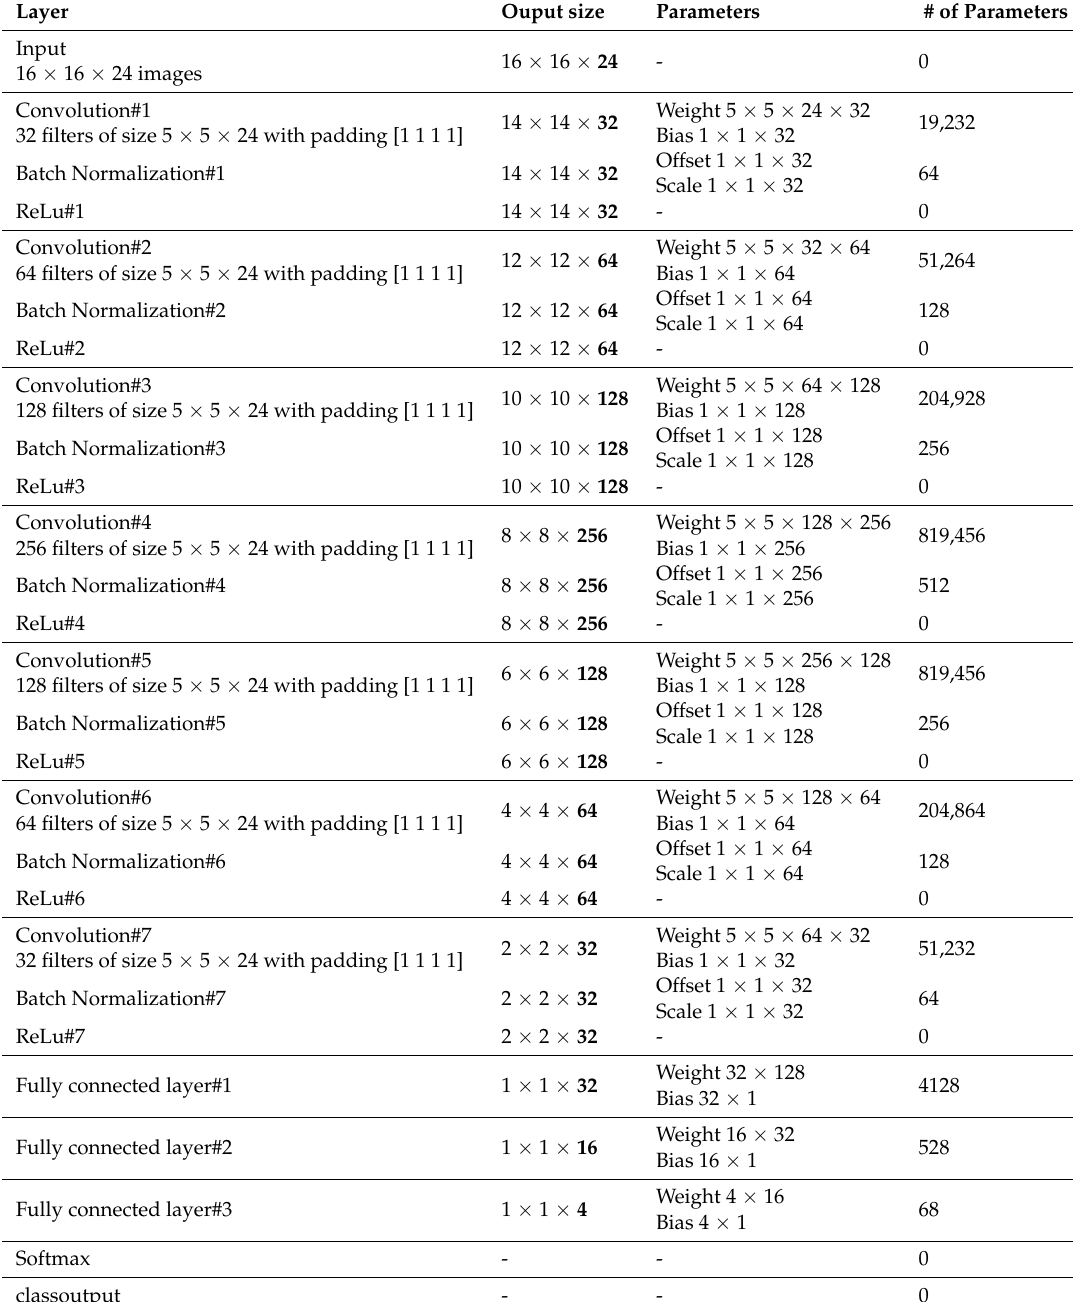
Table 4. Characteristics of the designed CNN. The neural network has a total of 2,176,308 parameters. The number of output channels in each layer is highlighted in boldface